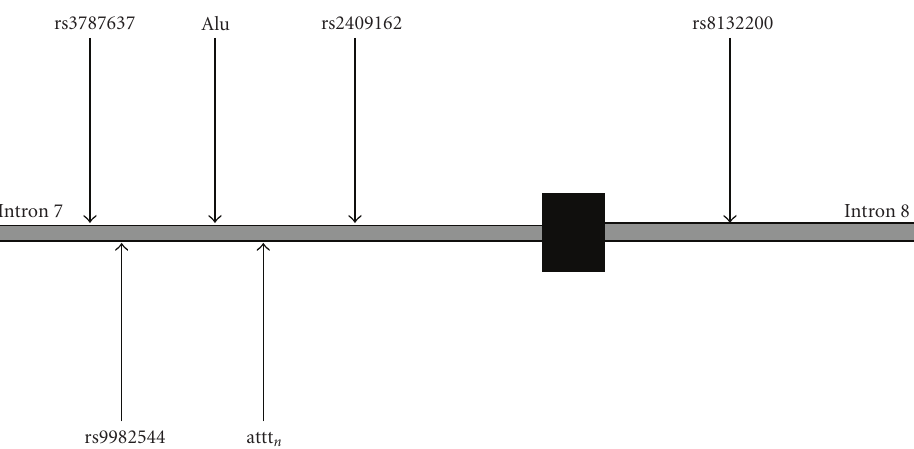
Figure 2: Diagrammatic representation of introns 7 to 8 of APP showing the locationsof the tetranucleotide repeat, Alu sequence and closest SNPs. Grey bars indicate introns and black bar indicates exon 8. Figure is not to